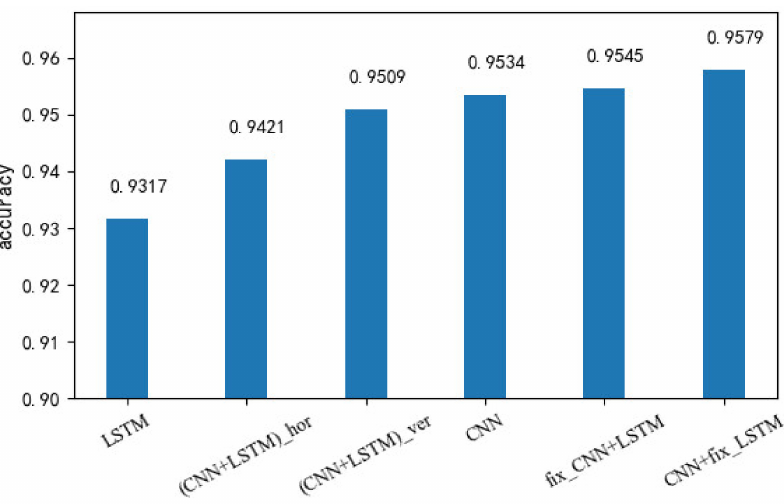
Figure 9. Accuracy of different network combinations.